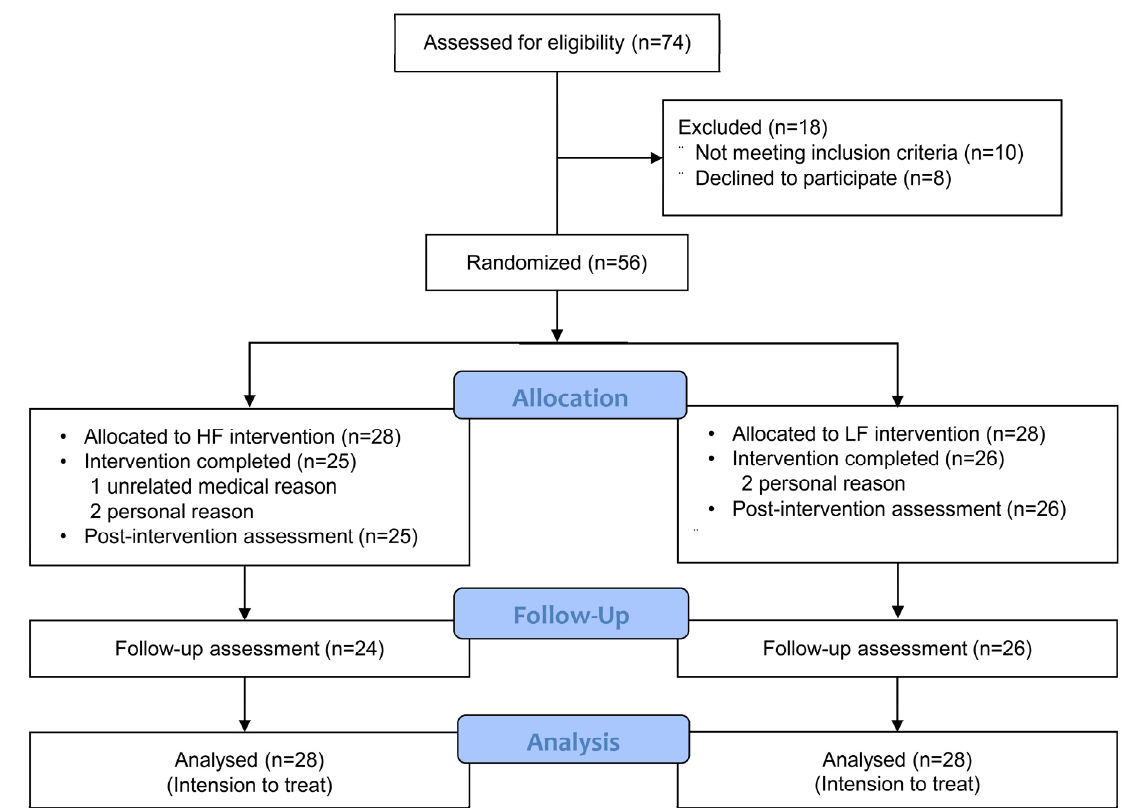
Figure 2. Study Figure 2. Study Flowchart. Table 1. Baseline Characteristics of the Participants.